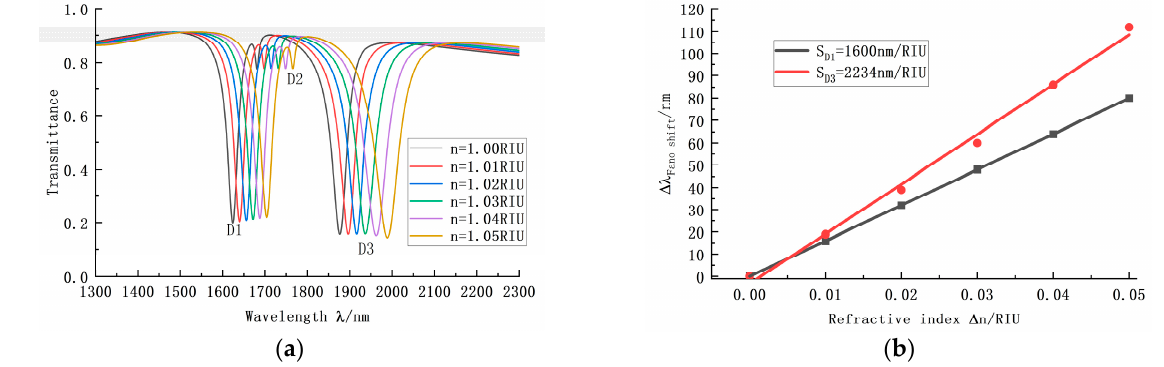
Figure 8. ( a ) Transmission curve of the IZRR structure with varying refractive index. ( b ) Sensitivity curve fitting of the IZRR structure with varying refractive index.